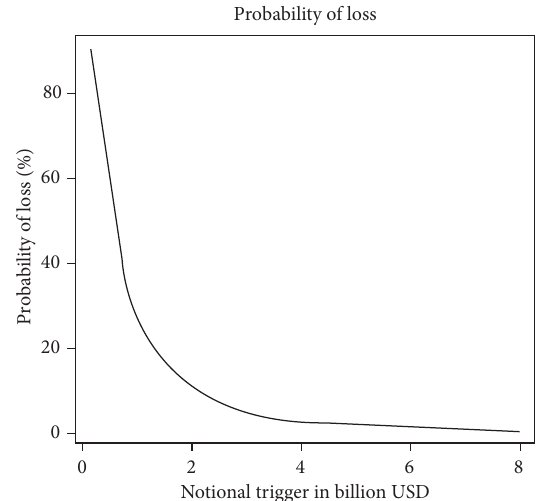
Figure 21: Cyber bond probability of loss for the period of 3years.